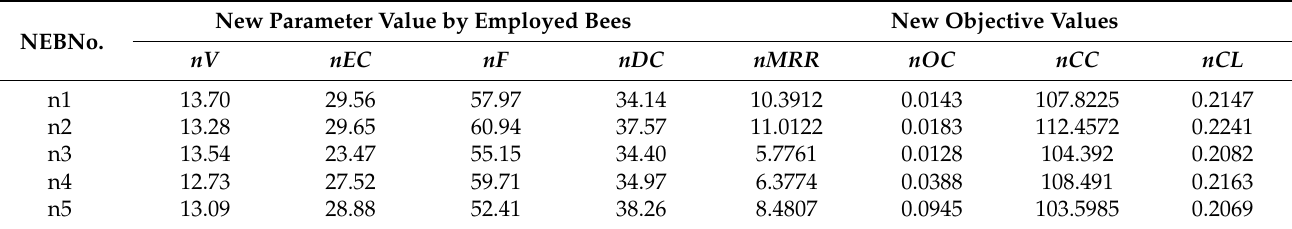
Table A8. New food by employed bees.